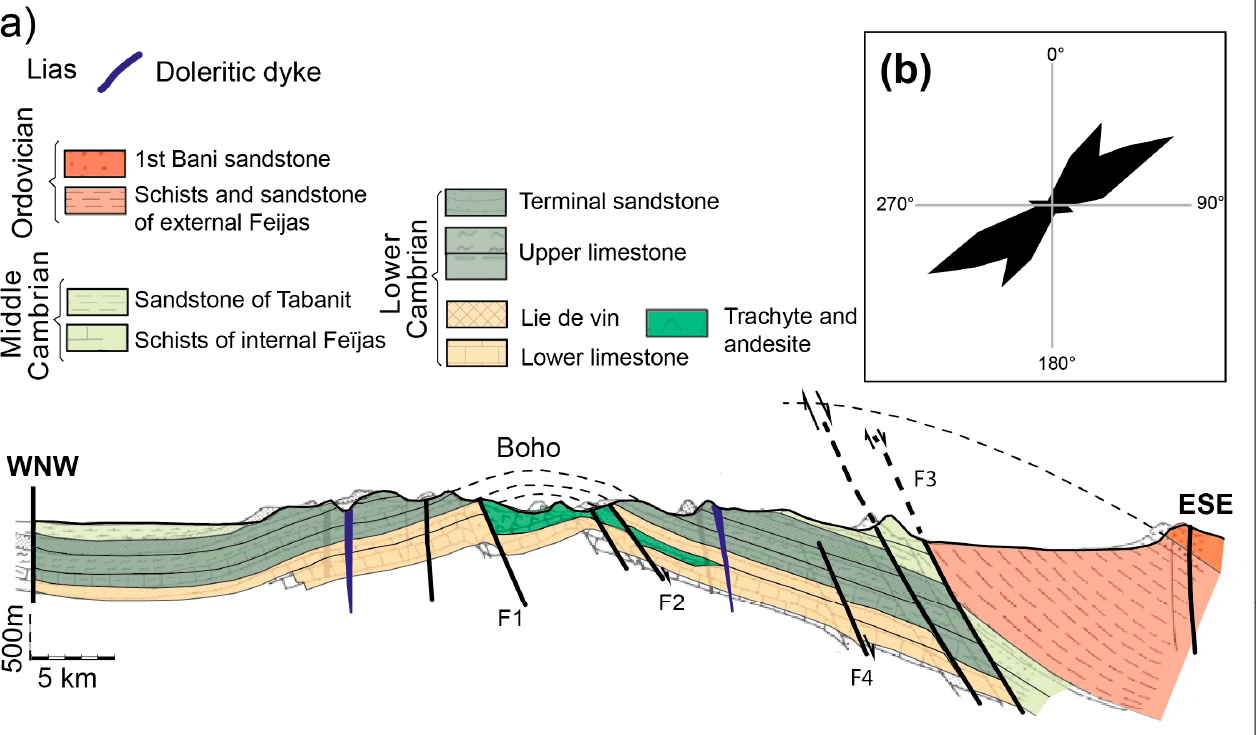
Figure 6. (a ) Geological section of the Foum-Zguid area (E-F section in Figure 1). ( b ) Rosettes of the cumulative length-weighted frequencies of fractures recorded on Landsat MSS space images for the Cambrian identification of the pushover of the eastern and southern edges of the Bou Azzer-El Graara inlier (adapted from Emran and Chorowicz [89]).